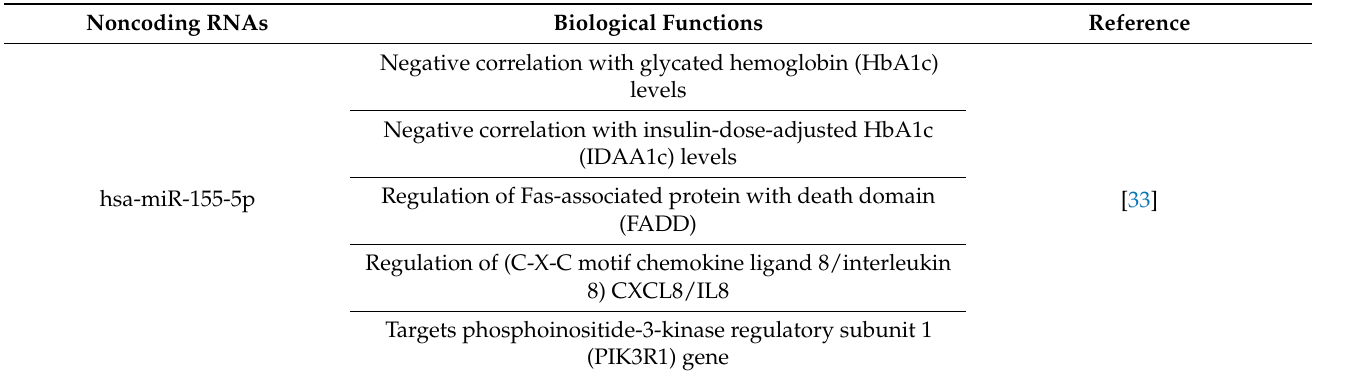
Table 8. Functional relevance of dysregulated noncoding RNAs. Noncoding RNAs Biological Functions